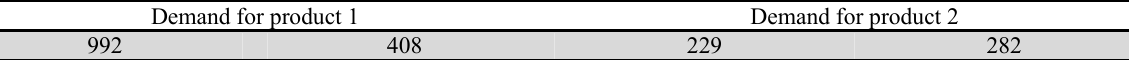
Payoff table TCOST INV TSERVL TCOST 137681.8